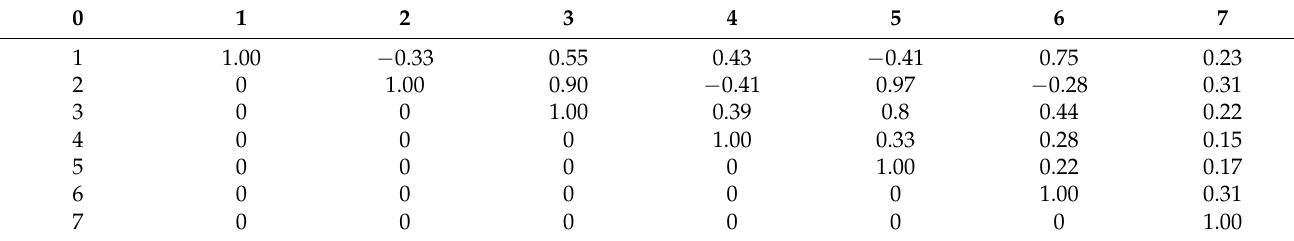
Table 7. Coordinate functions β